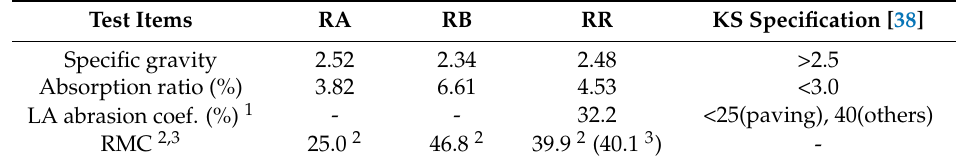
Table 1. RCA material properties; RA: Type A recycled aggregate; RB: Type B recycled aggregate; RR: Recycled aggregate derived from Railway concrete sleepers; KS: Korean standards.